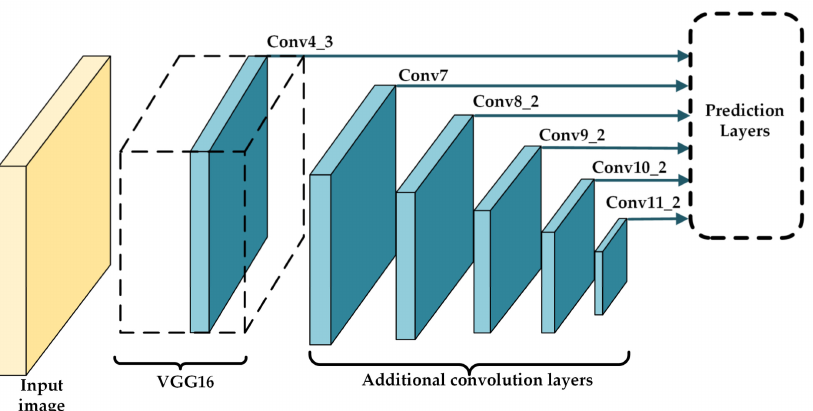
Figure 1. The Single-Shot MultiBox Detector (SSD) model consisting of a VGG and additional convolution